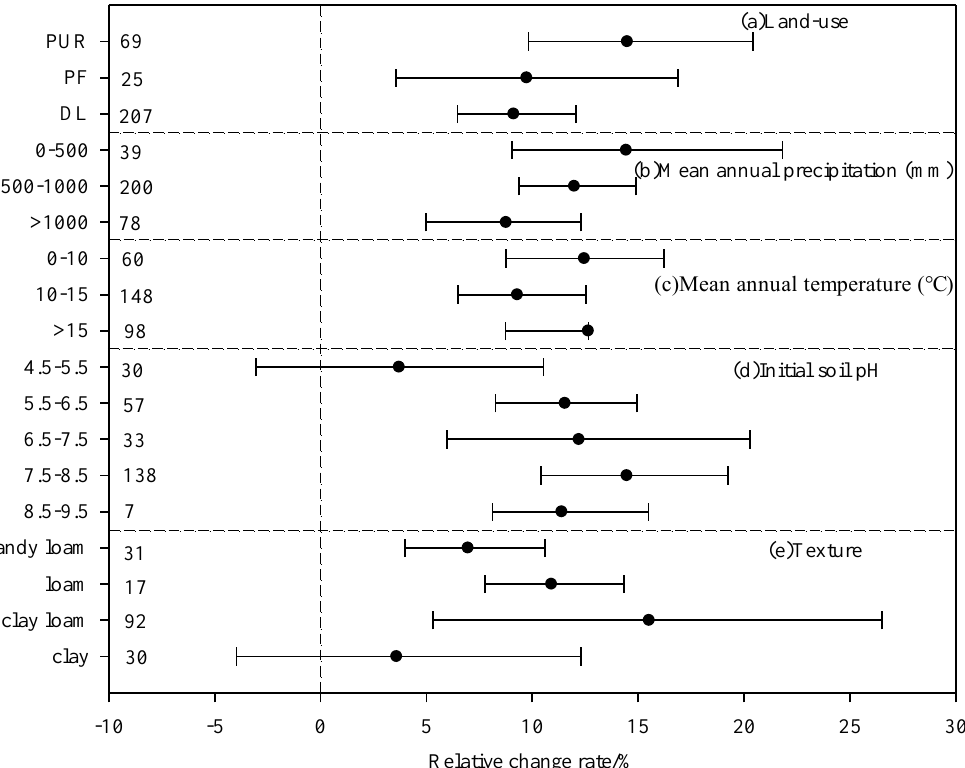
Figure 4. Relative change rate of SOC storage responding to residue retention under climate and soil resources. PUR: paddy-upland rotation; PF: paddy field; DL: dry land. Vertical axis represents invalid line, error bars represent 95% confidence intervals, the numbers to the right of the vertical axis are numbers of comparisons; if confidence intervals do not overlap with zero, it indicates significant increase (>0) or decrease (<0) ( p < 0.05).